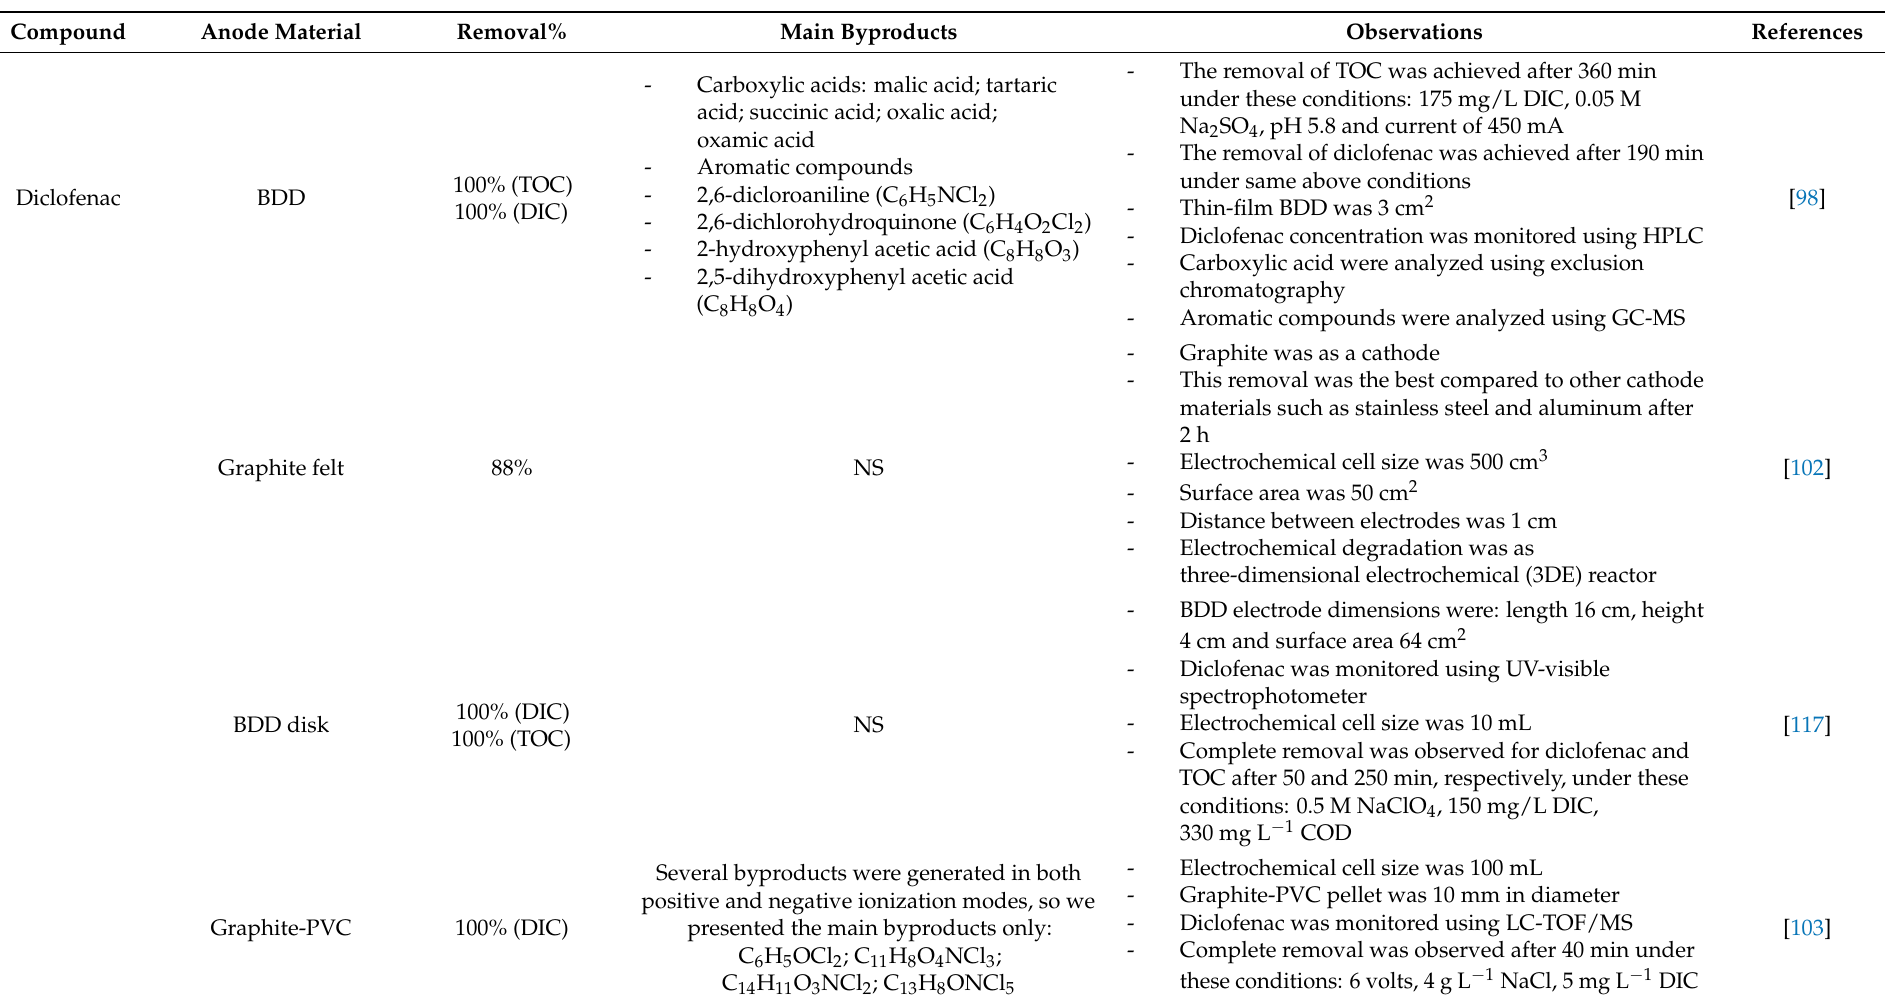
Table 4. Electrochemical degradation of selected NSAIDs using a carbon-based